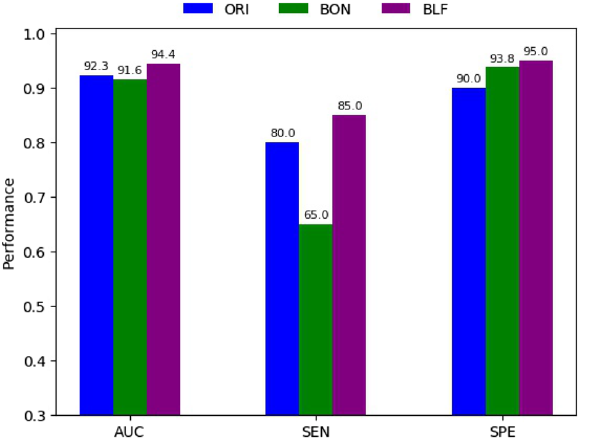
Figure 8. Performance of ORI, BON, and BLF over the MClass-D dataset using a prediction threshold of 0.5.